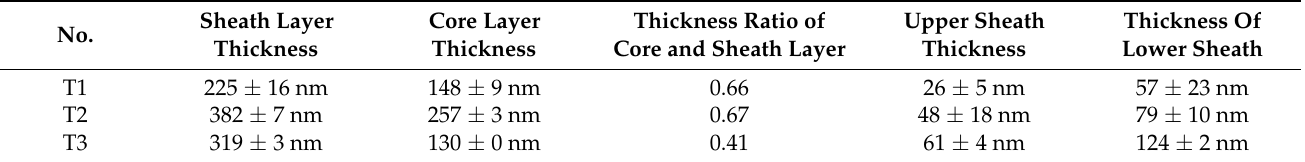
Table 2. Details of the thickness in modified triaxial electrospun